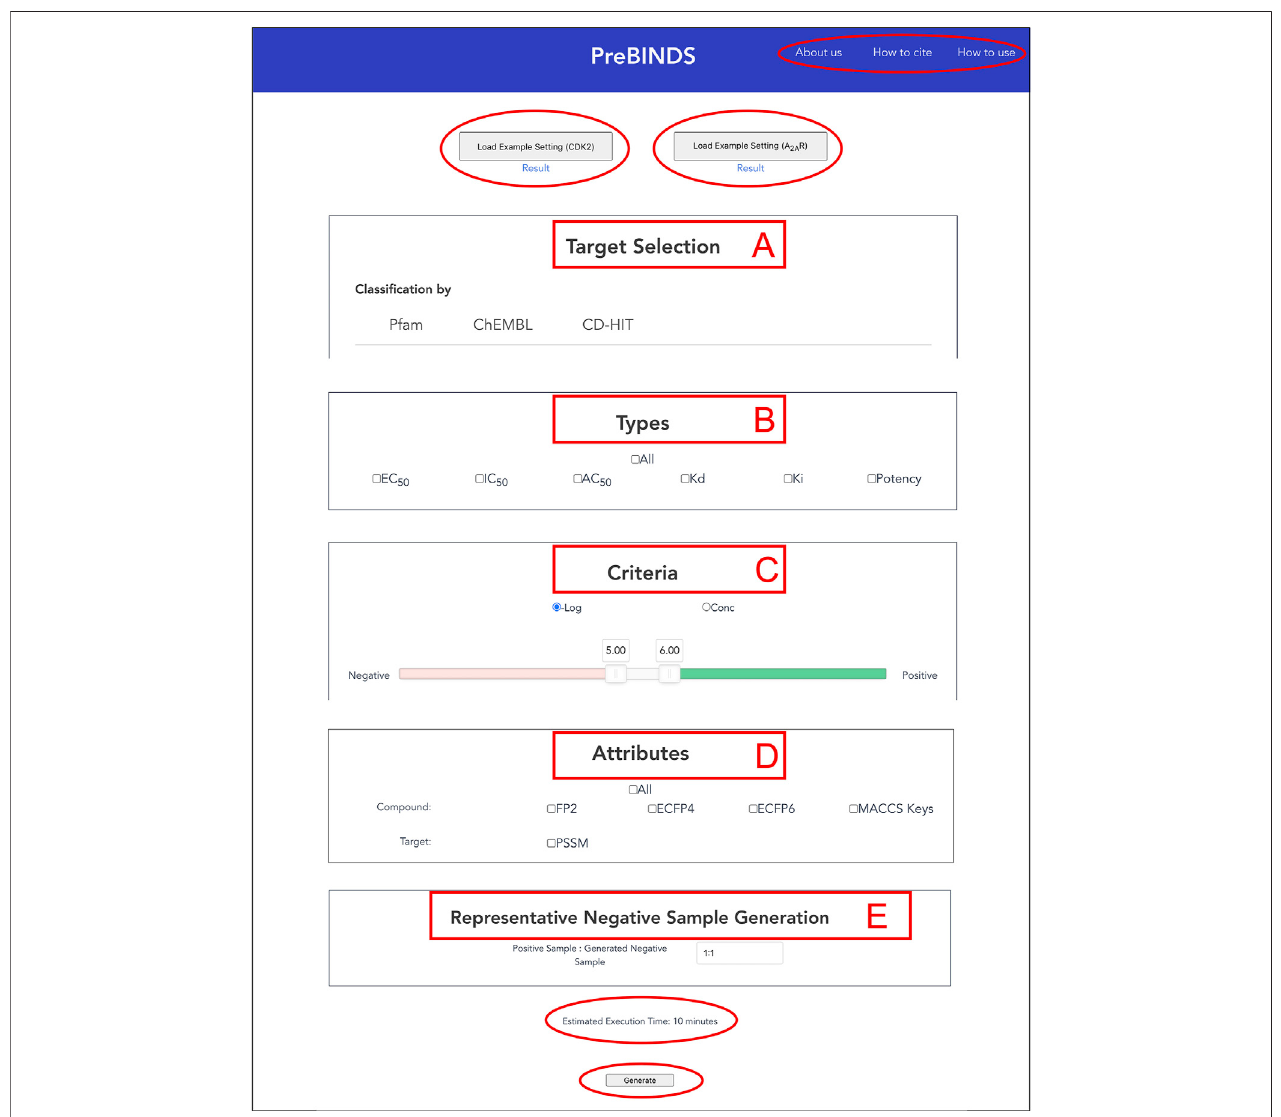
FIGURE 1 | Partial view of the web server interface, which is designed to be simple and easy to use, allowing users to select and retrieve compound – protein interactiondatasetsquicklyandinteractively.Userscon fi gurestheirdatasetin fi vesteps: (A) Selectproteintargets( “ TargetSelection ” ), (B) Selectactivitytypes( “ Types ” ), (C) Set activity data thresholds ( “ Criteria ” ), (D) Select compound and target attributes for output ( “ Attributes ” ), and (E) Set and generate negative data ( “ Representative Negative Sample Generation ” ). At the top of the interface, the “ How to use ” link leads to a brief instruction of this web server. “ About us ” and “ Cite us ” links respectively lead to information of developers and citations of this web server. “ Load Example Setting ” buttons provide sample setting parameters for generating datasetsoftworepresentativetargets(A2ARandCDK2)anddownloadlinkstoobtaintheoutput fi les.Atthebottomoftheinterface,userscan fi ndtheestimatedtimeto complete the submitted dataset generation job in